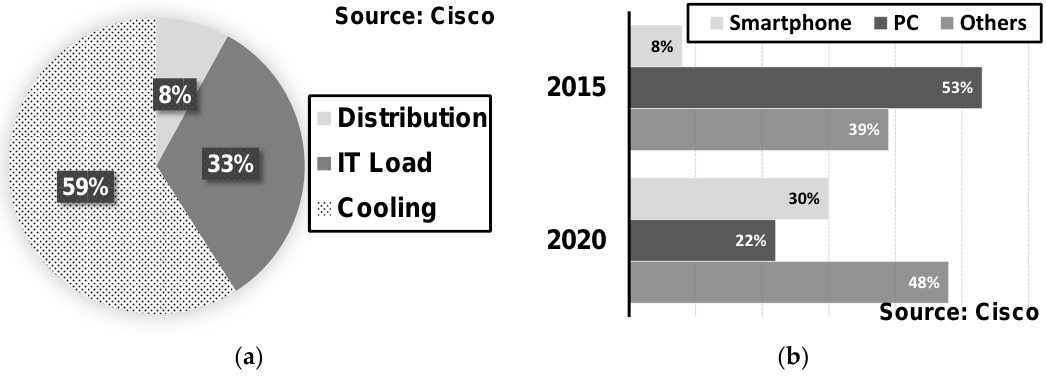
Figure 3. ( a ) Power breakdown of data centers and ( b ) forecast of IP traffic contribution [1].